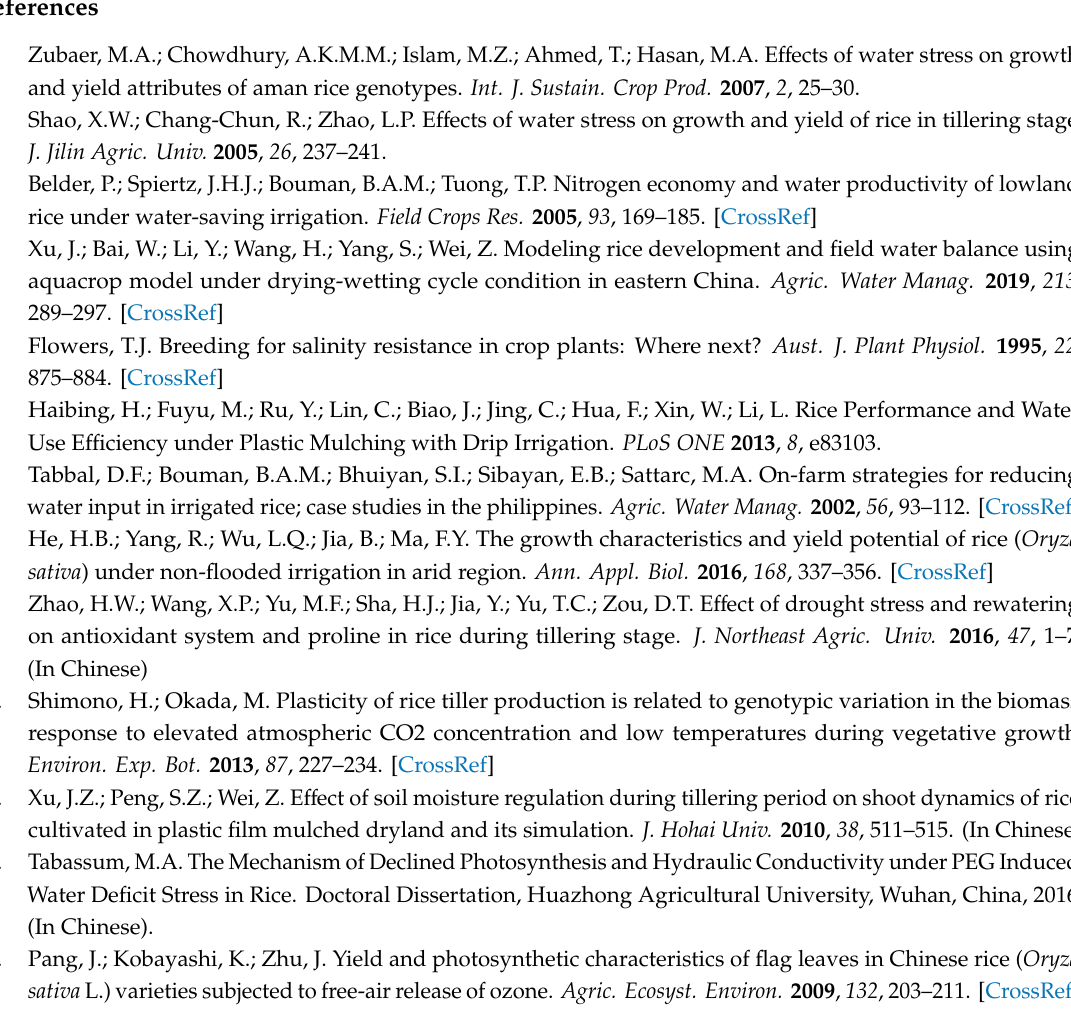
Figure S1: The experiment took place in (a) China, in (b) Xinjiang in (c) the oasis agroecosystem at (d) the Erlian Key Laboratory of Modern Water Saving Irrigation Corps. Figure S2: Average daily temperature and rainfall of rice in the growth period of the Shihezi region in (a) and